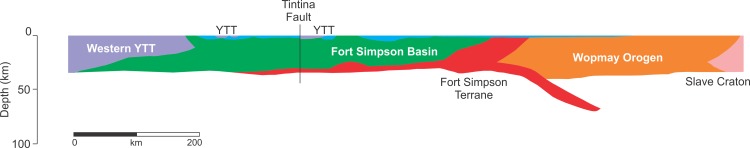
Seismic cross-section of the crust.Crustal-scale section across the North American Cordillera. Interpretations are based on reflection seismic data [11]. Undivided Proterozoic includes Paleo- to Neoproterozoic strata. The Paleoproterozoic Fort Simpson Basin formed after rifting and attenuation of Fort Simpson terrane crust at approximately 1.8 Ga, and was filled by continental slope and terrace deposits before 1.6 Ga. The western portion of greater Yukon-Tanana terrane (YTT) includes parts of other pericratonic terranes [10].